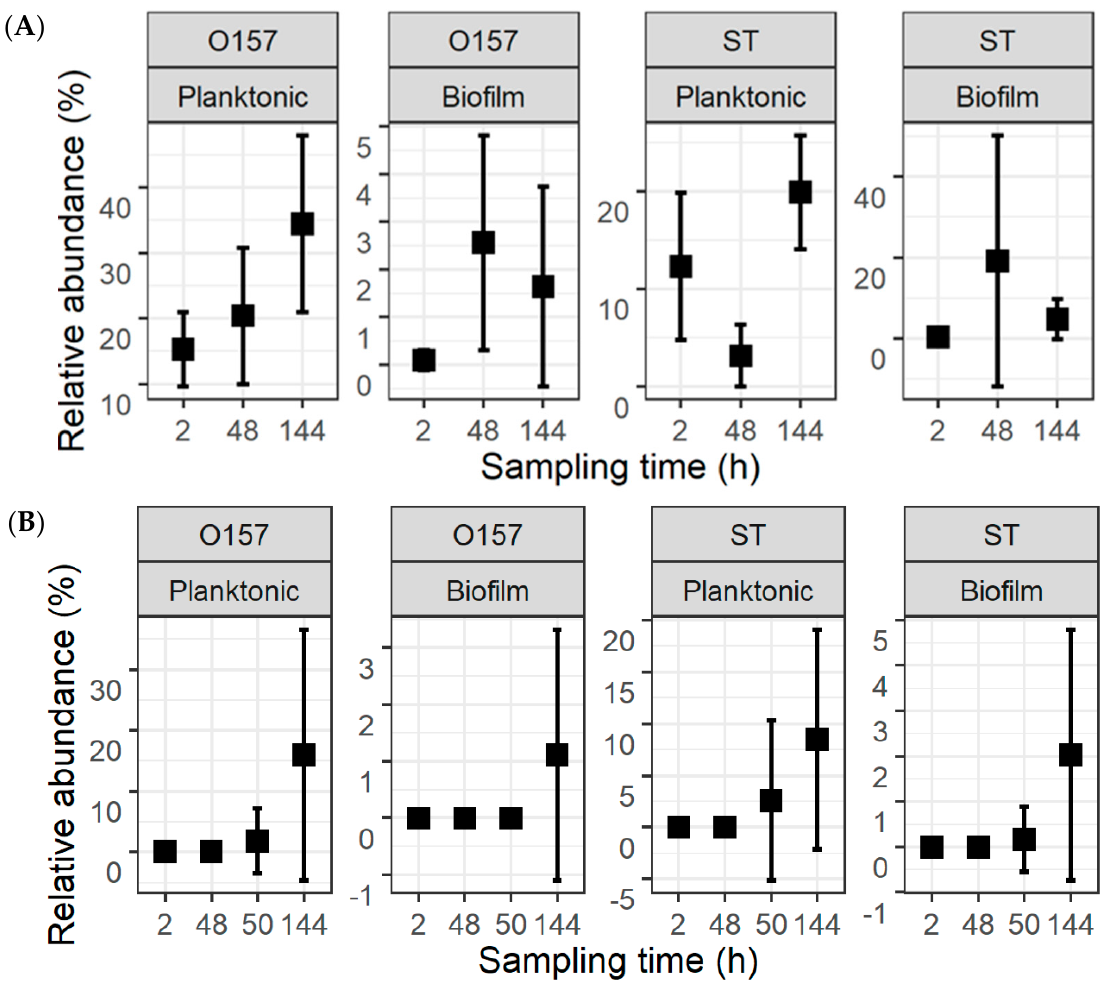
Figure 4. Relative abundance of Escherichia coli O157:H7 (O157) and Salmonella Typhimurium (ST) within the total population of bacteria. The pathogens were introduced simultaneously with meat processing surface bacteria ( A ) or delayed by 48 h ( B ). This is replotted with information in Figures 2 and 3 to highlight the fractions of the two